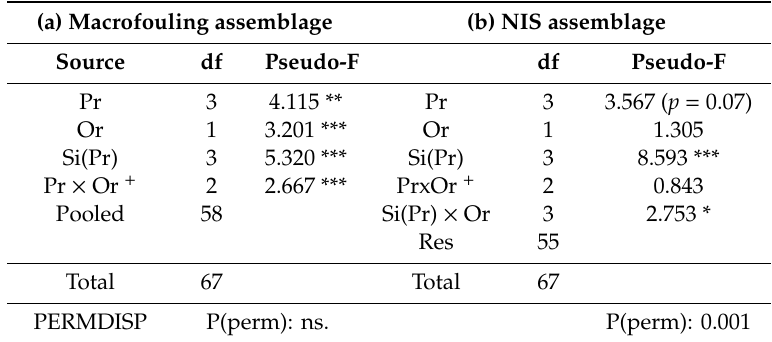
Table 6. Multivariate analyses of variance of a) total macrofouling assemblage and b) macrofouling assemblage accounting only for non-indigenous species (NIS), across “Pressure” levels (Pr), “Origin of biofilm” (Or) and “Sites” (Si(Pr)) after 15 weeks of panel deployment. Analyses are based on Bray–Curtis similarity matrices of square root transformed data. Pair-wise comparisons were performed when significant di ff erences were found (see Supplementary Materials Table